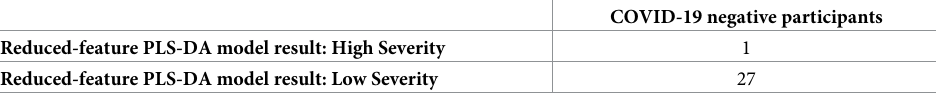
Table 2. Confusion matrix for reduced-feature PLS-DA model projected on to COVID-19 negative